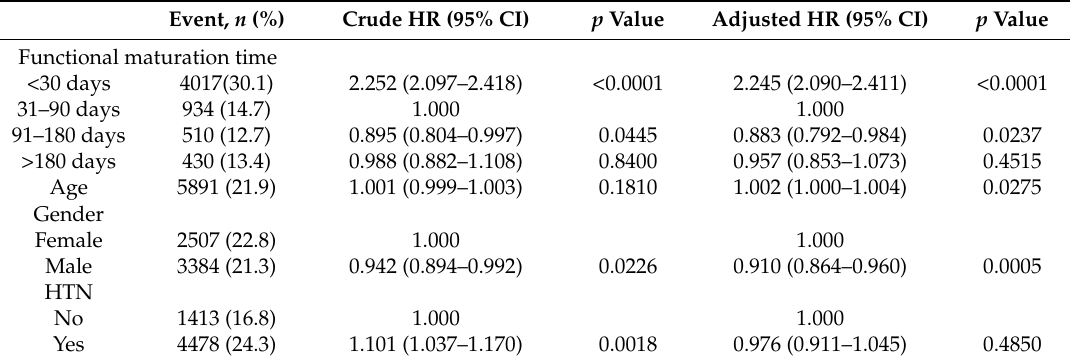
Table 2. Hazard ratios for functional cumulative survival of